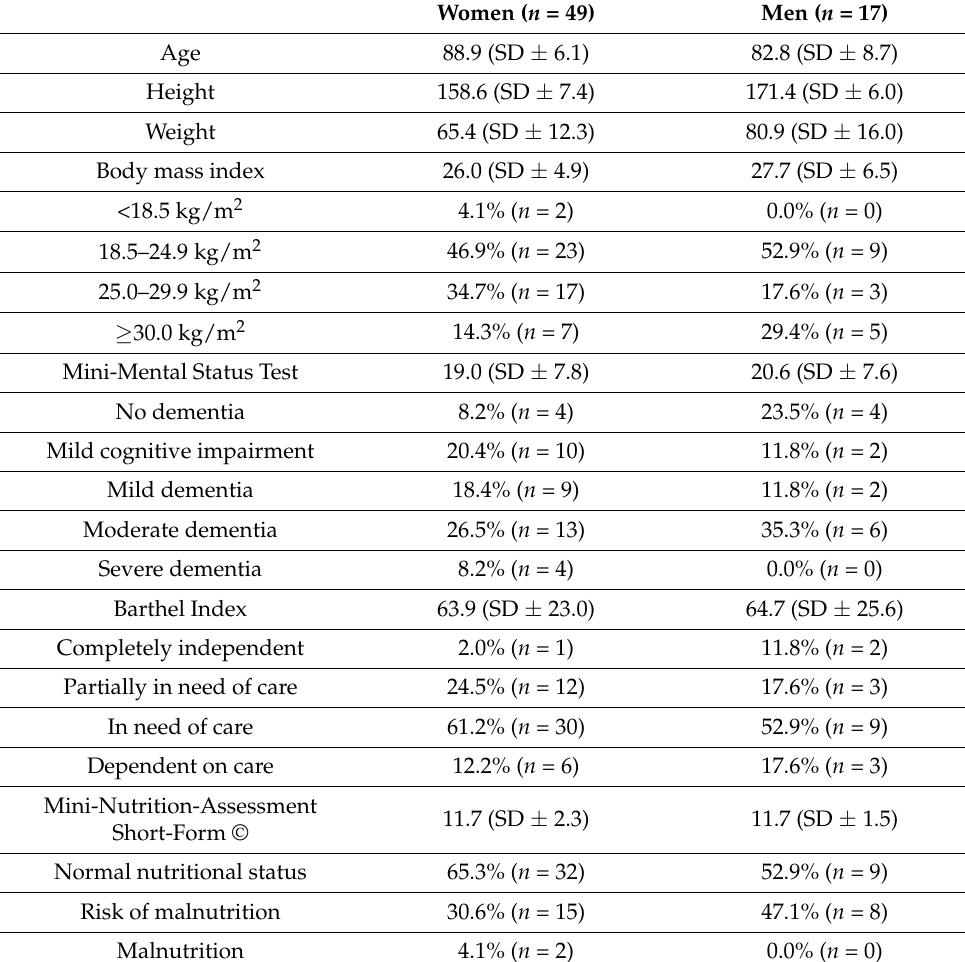
Table 2. Basic characteristics of the BaSAlt cohort.